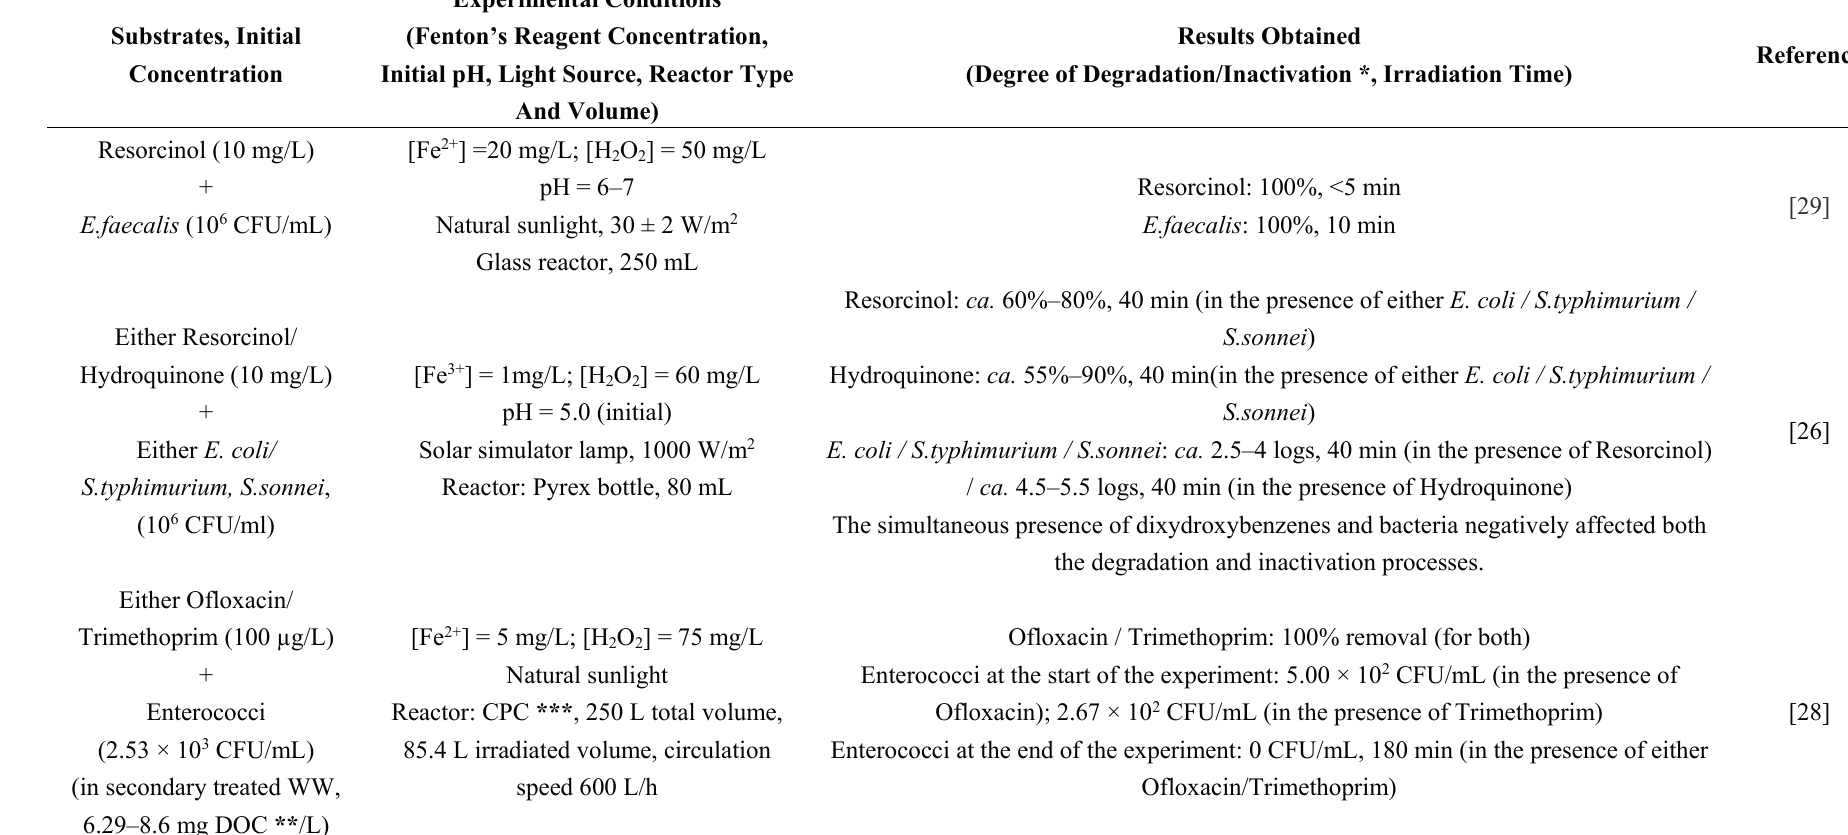
Table 2. Overview of the studies that employed solar-enhanced photo-Fenton for simultaneous removal of organic compounds and pathogens. Substrates,